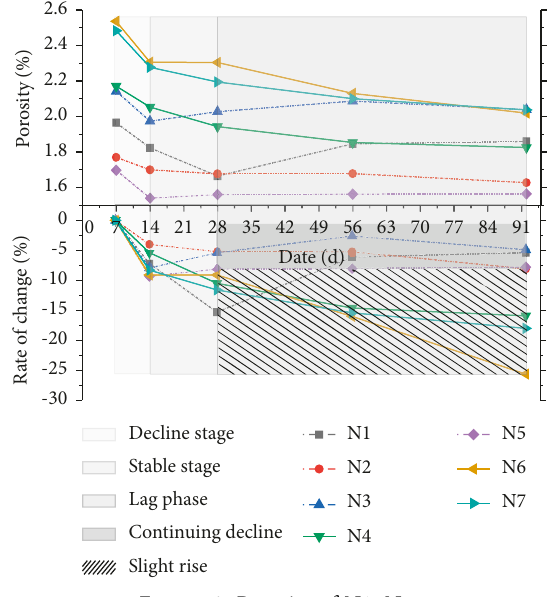
Figure 9: Porosity of N1 ∼